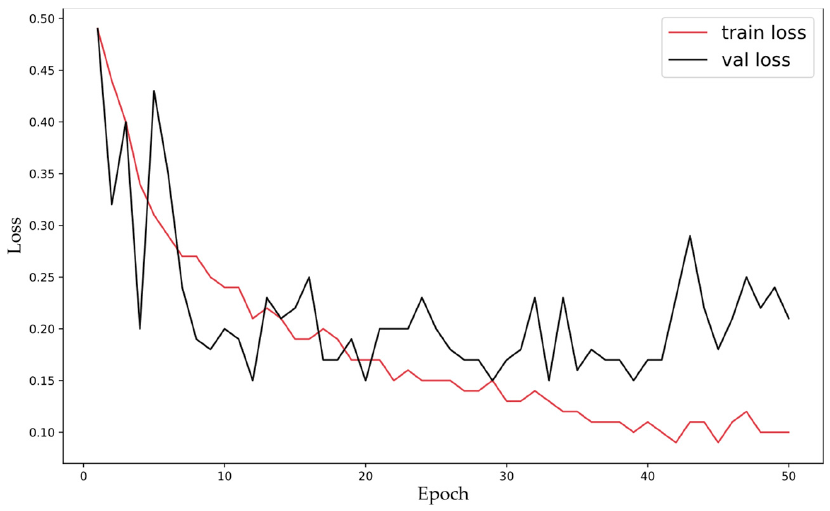
Figure 10. The change curve of the loss value in the training process of MobileNetv2.